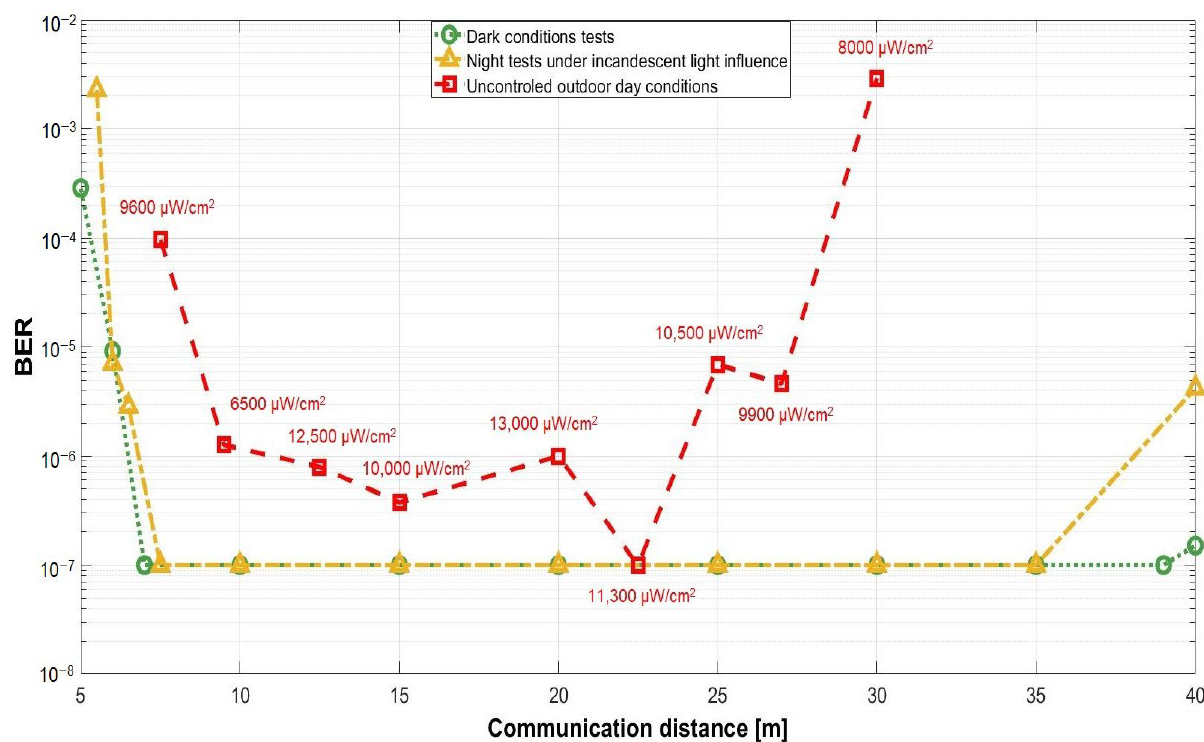
Figure 11. Bit error ratio results for the experimental evaluation of the visible light communications system in night conditions, under the influence of fluorescent lights, and in outdoor uncontrolled daytime conditions.